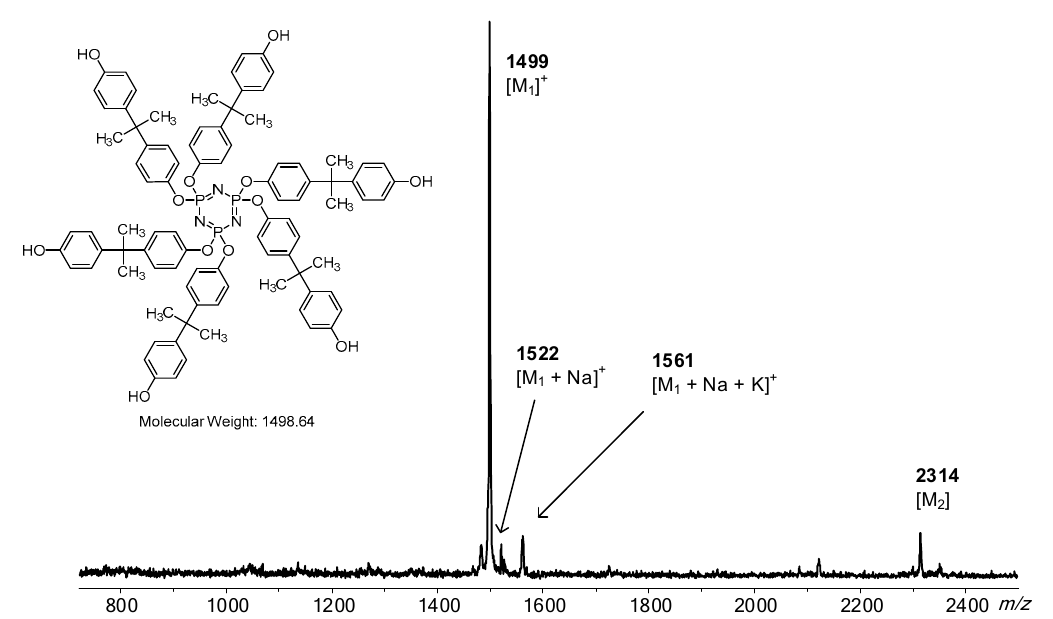
Figure 6. MALDI-TOF mass spectrum of hydroxyaryloxyphosphosphazenes synthesized at a molar ratio of HCP: bisphenol A = 1:12.